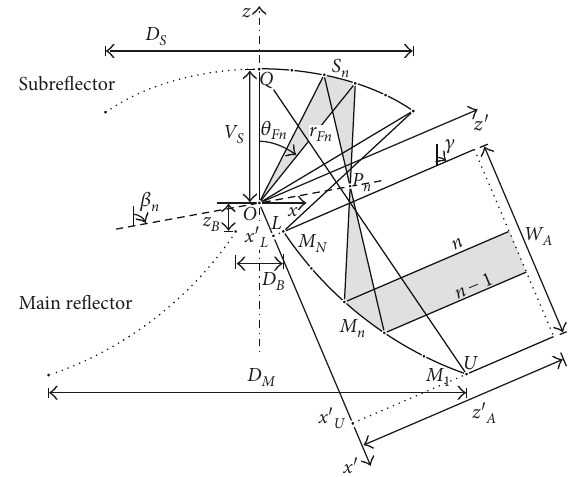
Figure 1: Geometry of the shaped omnidirectional ADE-like antenna.